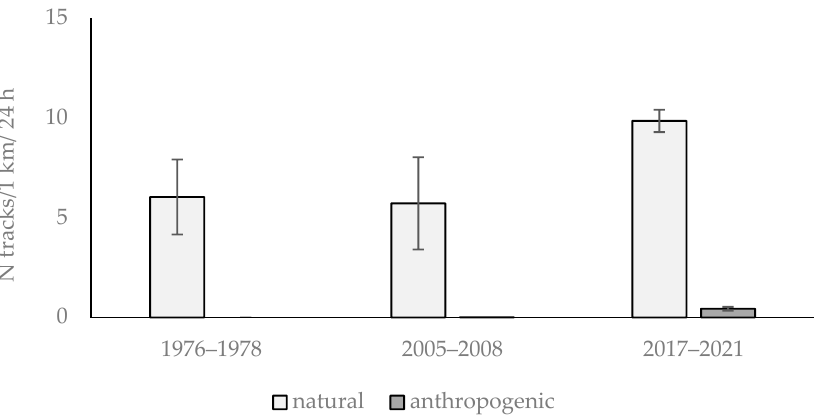
Figure 2. Mean (+SE) number of roe deer tracks in two different types of habitats in Warsaw as